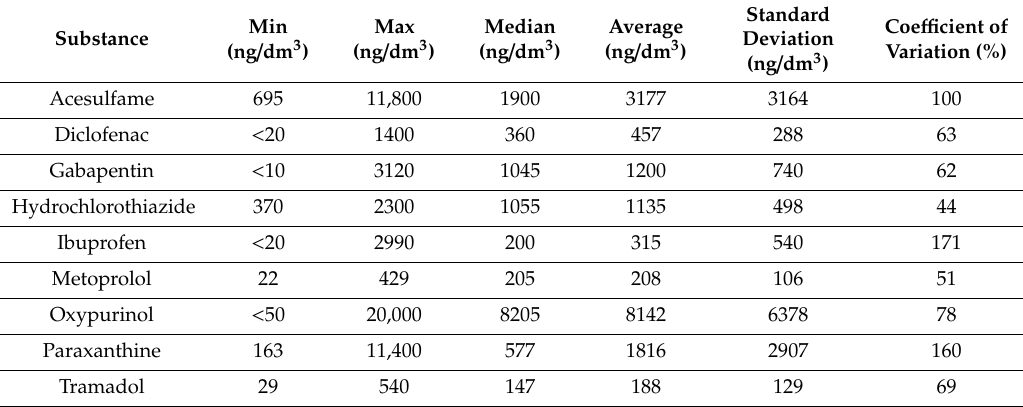
Table 6. Dolni Kralovice Profile—basic statistical